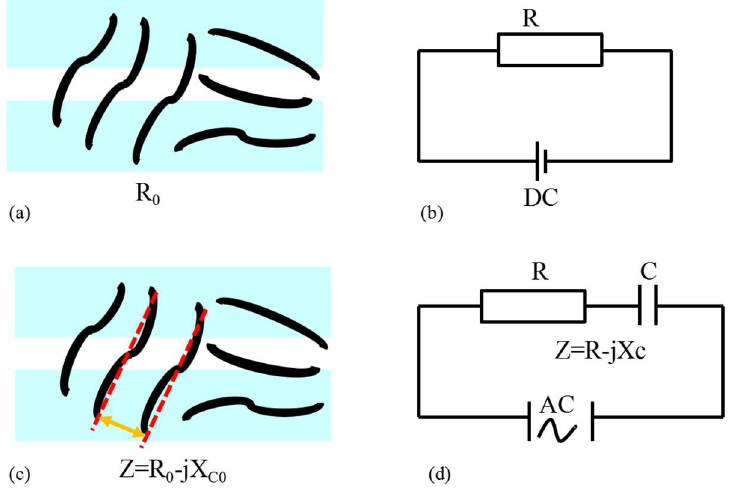
Figure 1. The equivalent circuit of CNT/PDMS force-sensitivity test ( a , b ) DC condition ( c , d ) AC